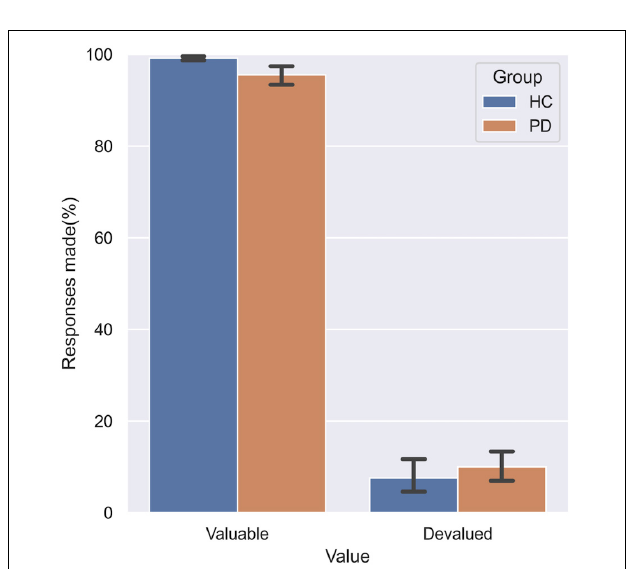
FIGURE 5 | Performance on the baseline test. No significant difference was found between the two groups in the responses made to valuable and devalued